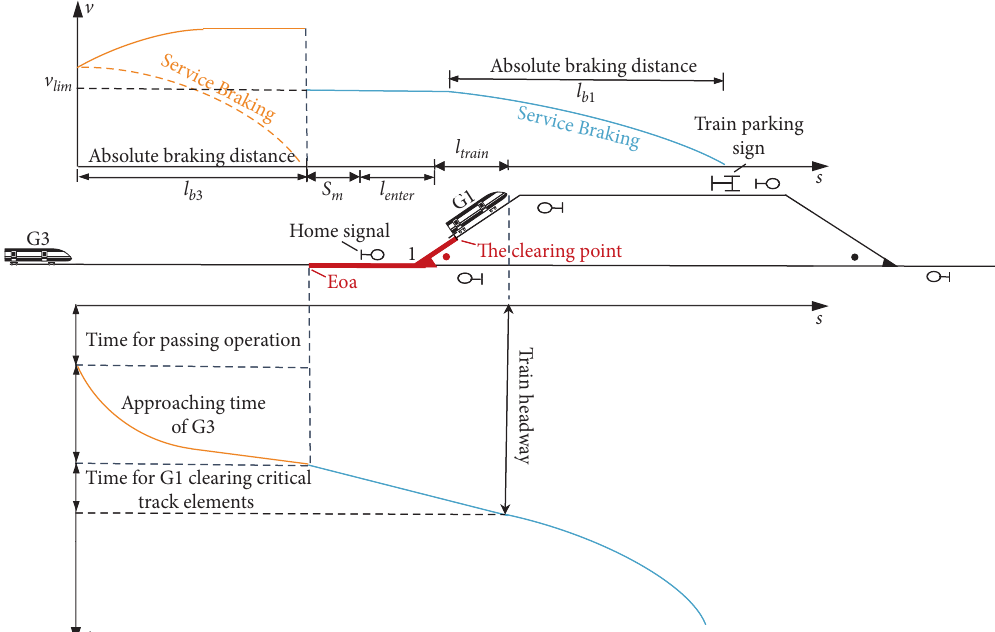
Figure 7: G1 arrives at the station and G3 passes through the station.